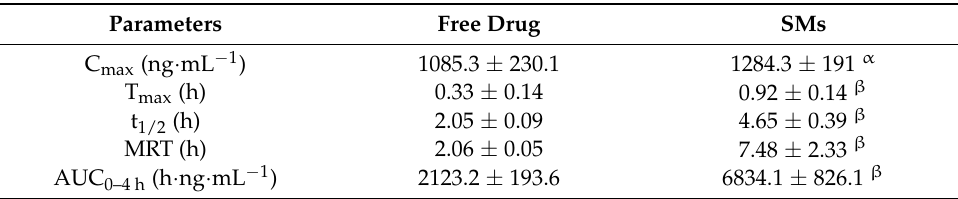
Table 2. Pharmacokinetic parameters of free 6 ‐ shogaol and 6 ‐ shogaol loaded micelles (SMs) after oral administration in rats (mean ± SD).